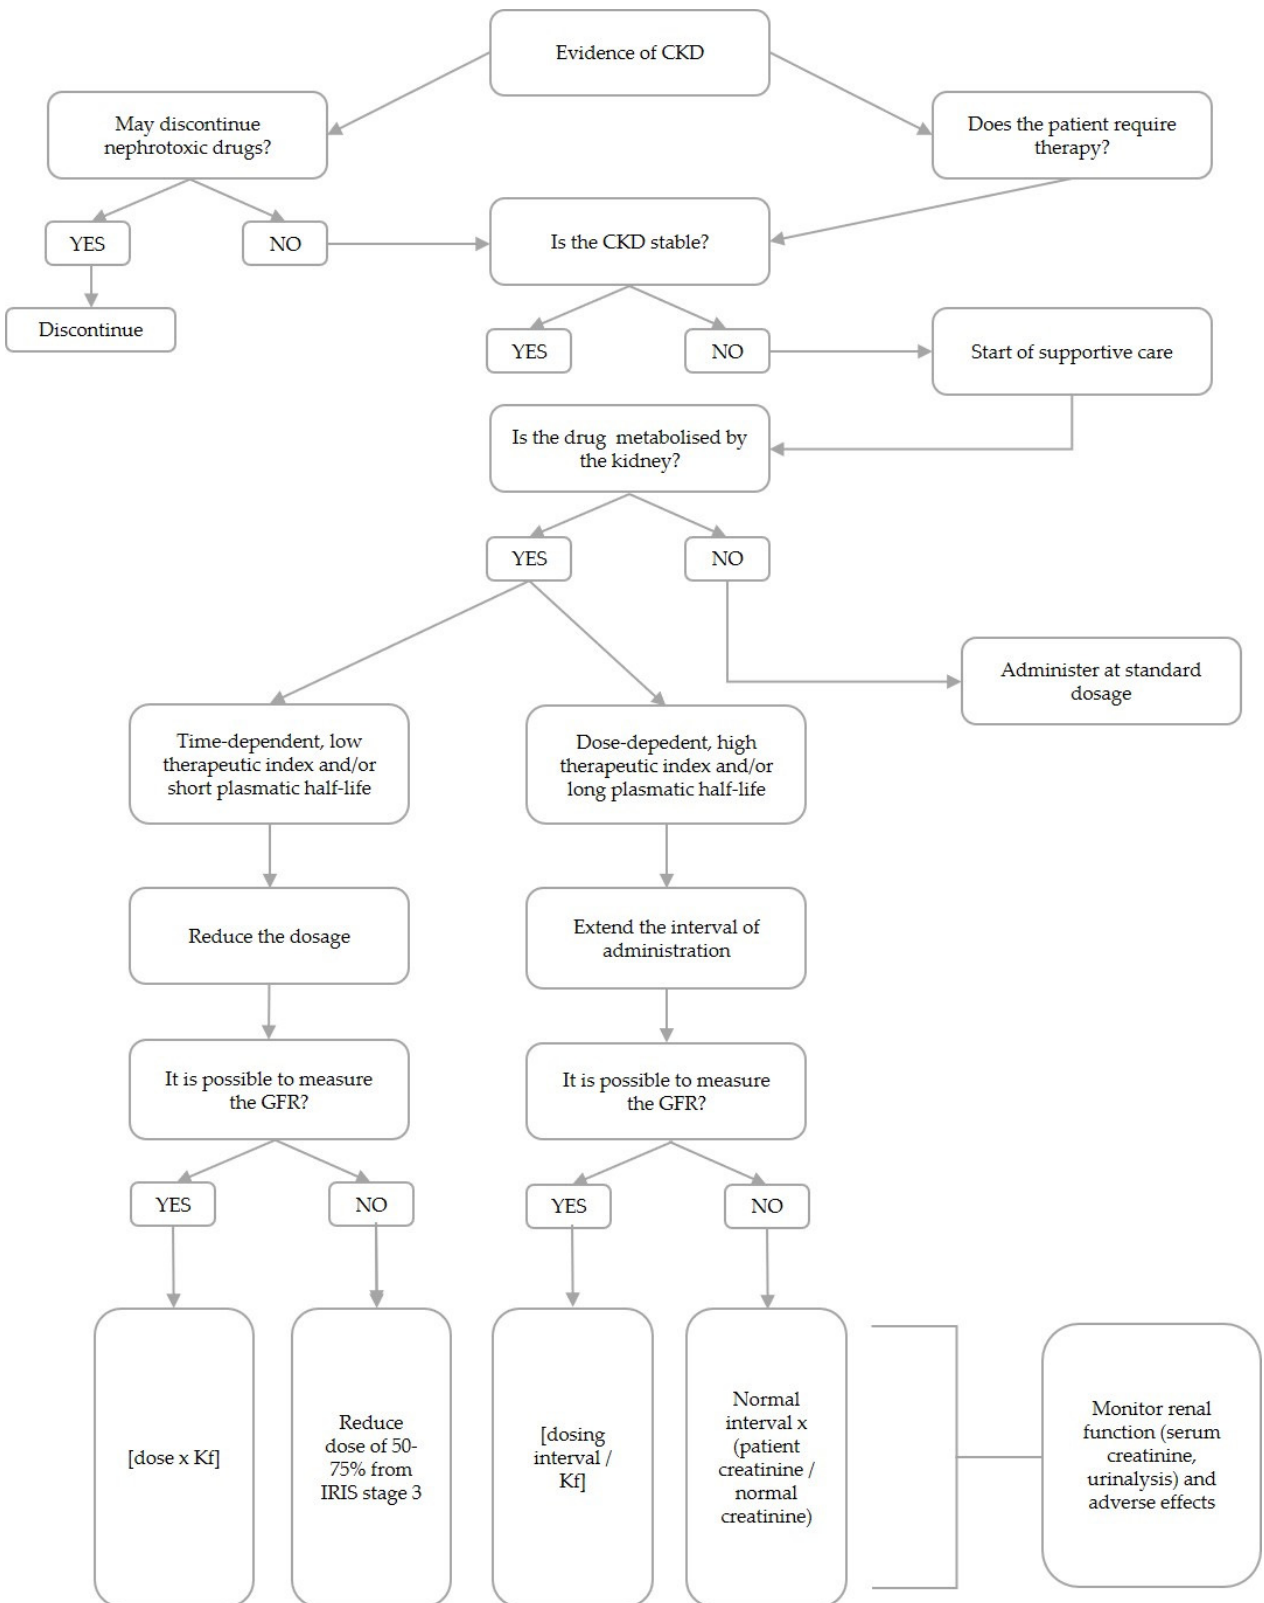
Figure 1. Proposed practical guideline for drug dosage adjustments in canine and feline chronic kidney disease. CKD: Chronic Kidney Disease; GFR: Glomerular Filtration Rate; Kf: Filtration Co- efficient.